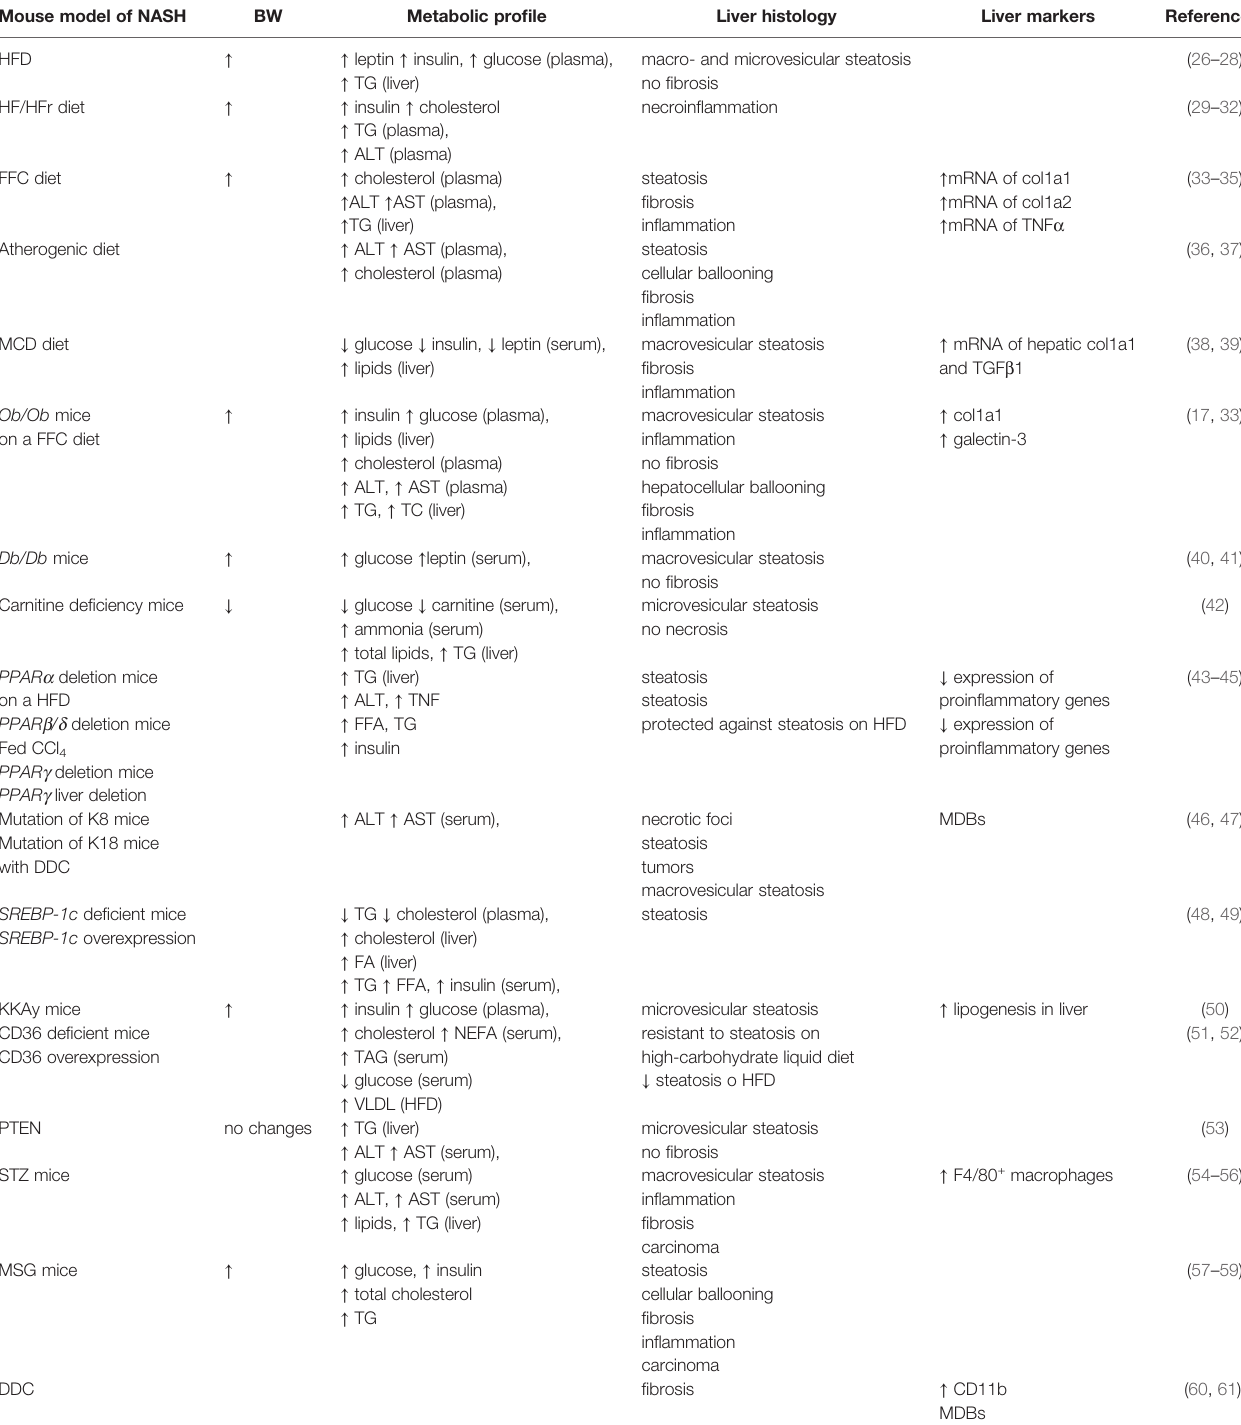
TABLE 2 | Mouse model and features of